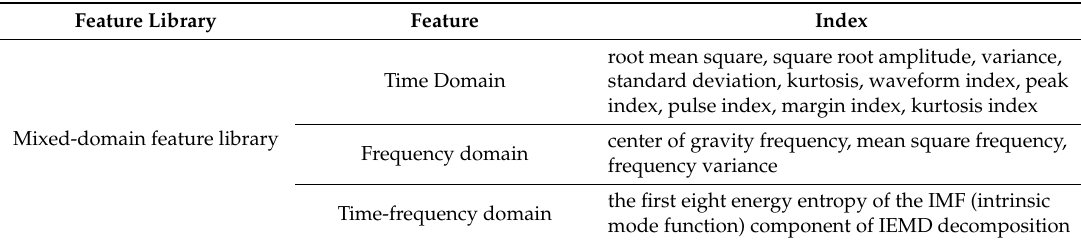
Table 1. Mixed feature library of vibration signals.